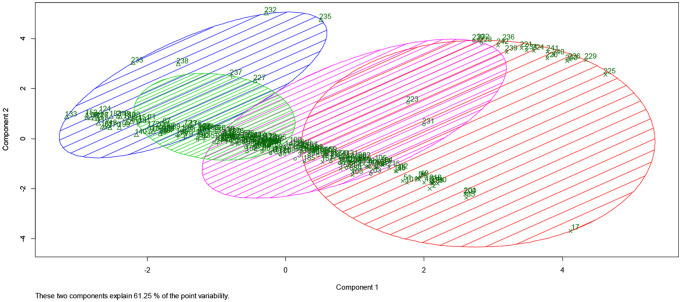
Cluster analysis.